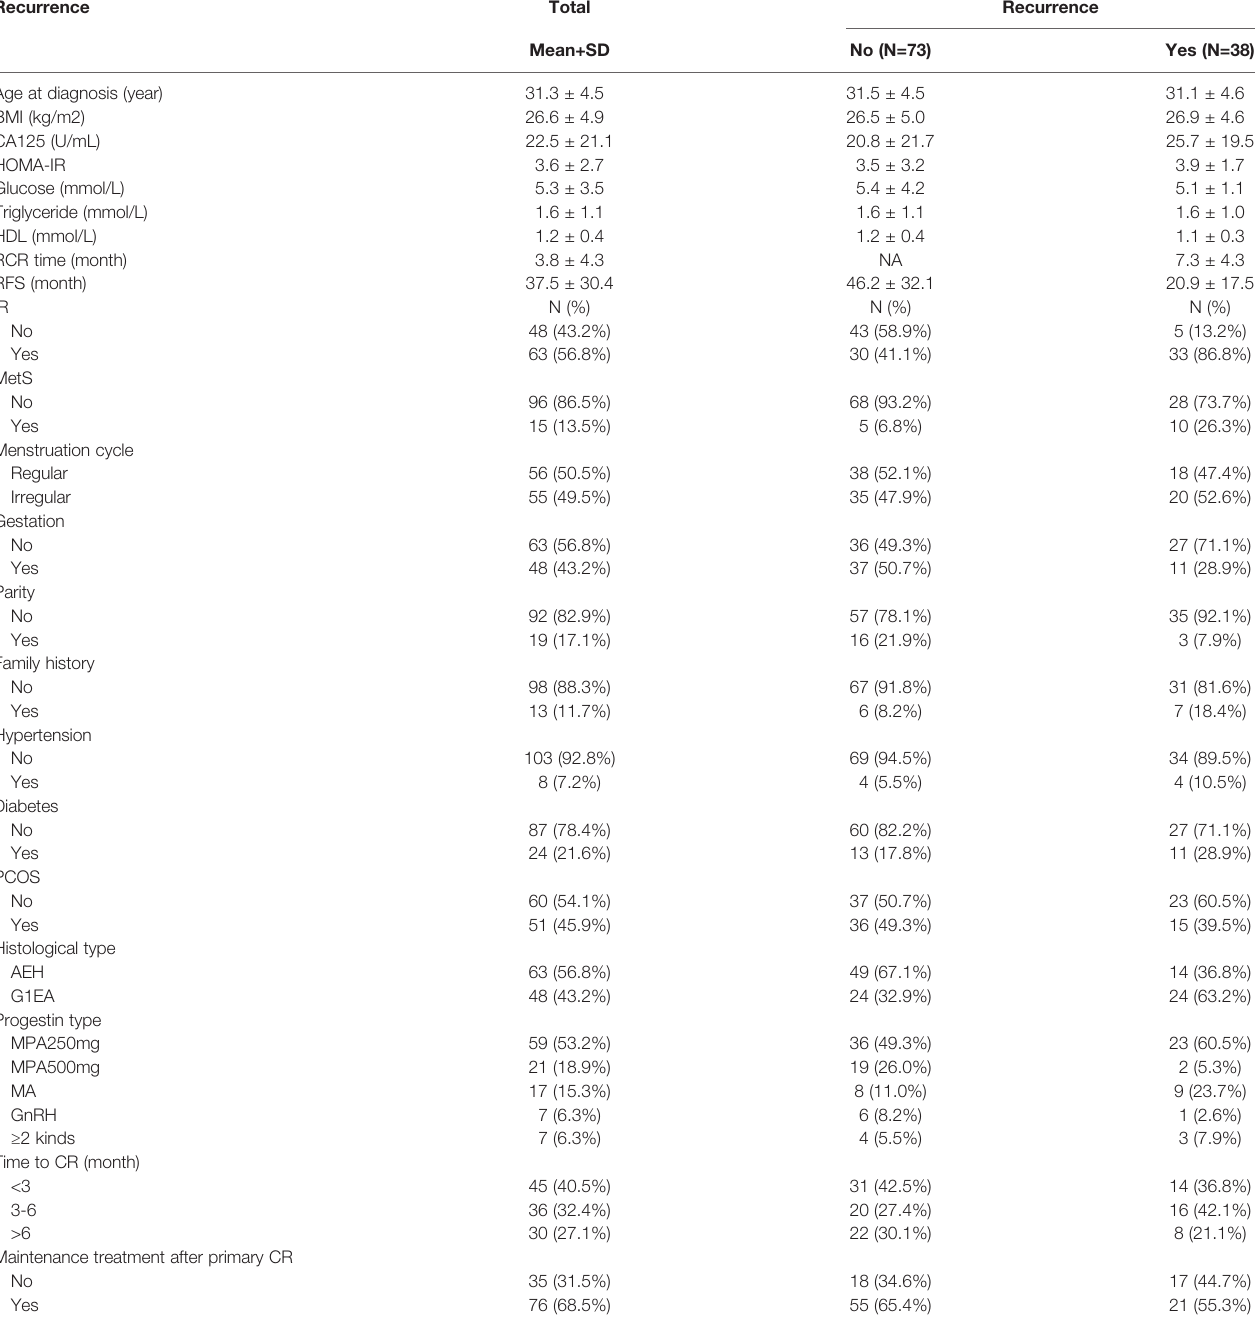
TABLE 1 | Clinicopathological characteristics and treatment in recurrence-free and recurrence group.